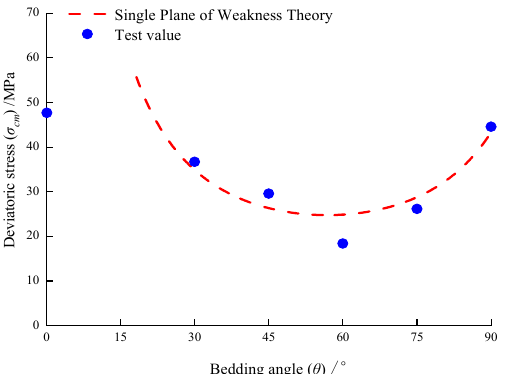
Figure 12. Deviatoric stress-axial strain curves of coal samples with different bedding angles under confining pressure of 9 MPa.